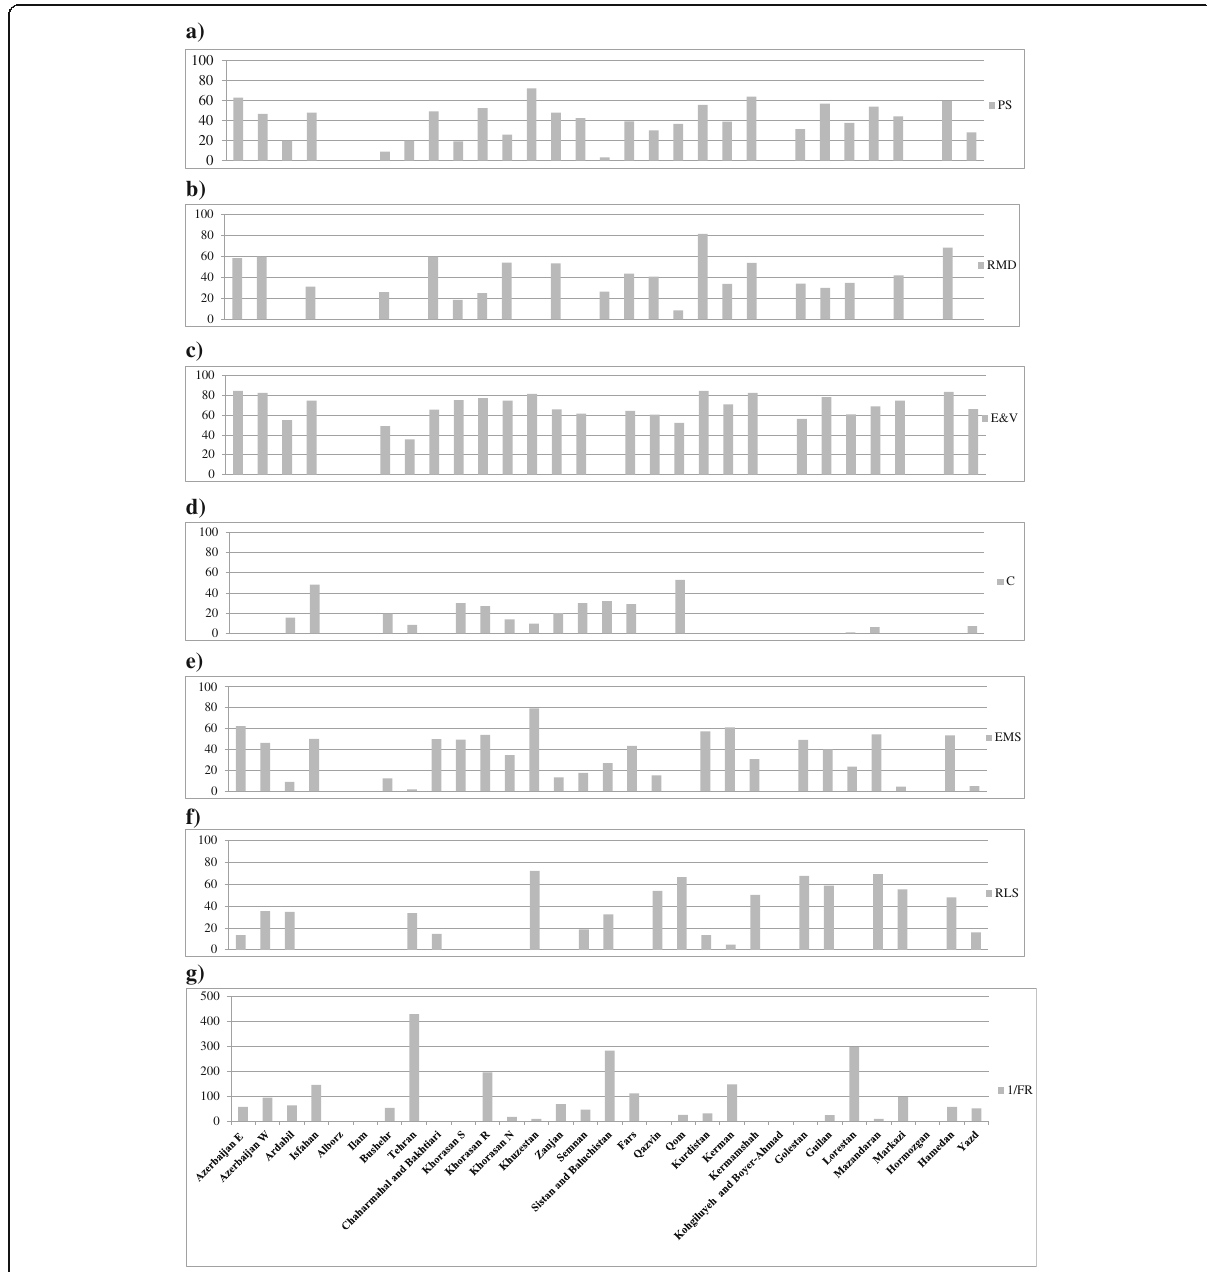
Fig. 11 Deviations of input and output variables for Iranian provinces in